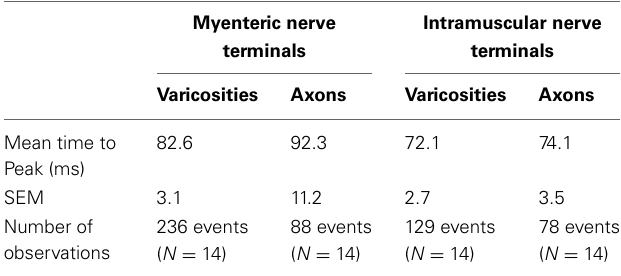
Table 1 | Characteristics of half duration of calcium transients in varicosities and axons of spinal nerve terminals that ramify within myenteric ganglia and circular muscle.